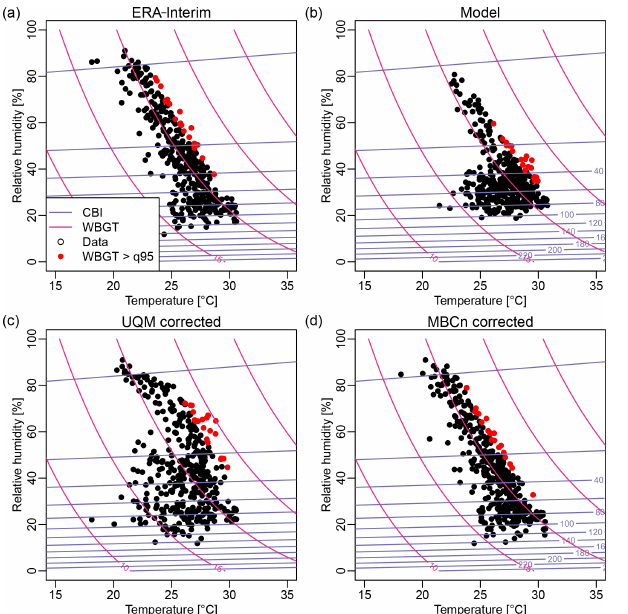
Figure 1. Distribution of daily temperature versus relative humid- ity during July (1981–1995) for a grid point in central Africa. ERA-Interim (a) ; model simulations from the model IPSL-CM5A- MR (b) ; bias-adjusted with UQM (c) ; bias-adjusted with MBCn (d) . Pink lines depict levels of equal heat stress (WBGT). Violet lines depict levels of equal fire risk (CBI). Red points denote values for which WBGT exceeds its 95th